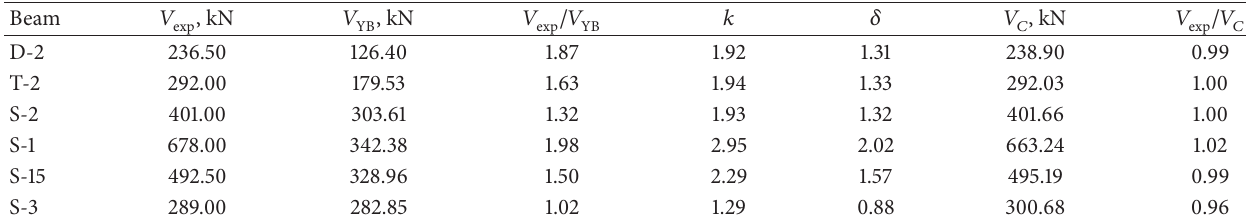
Table 5: Comparison between calculation and test values.